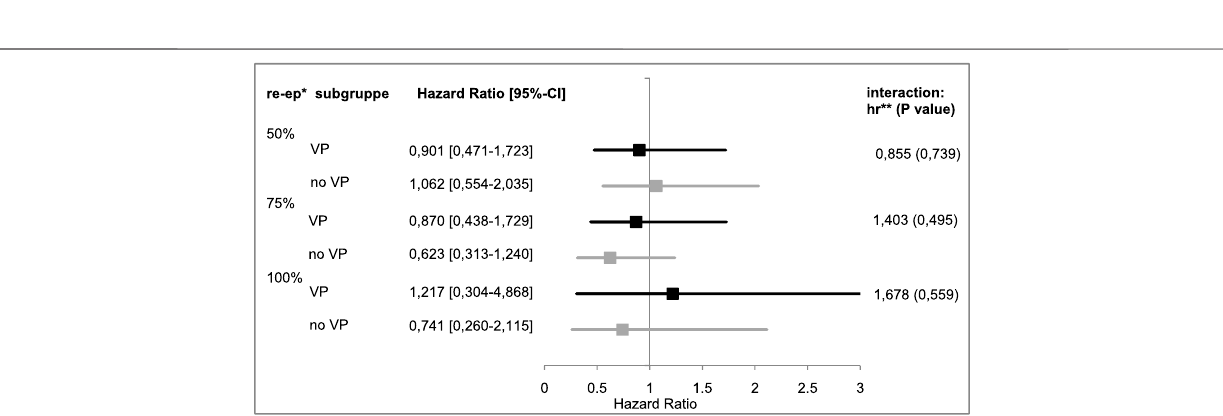
FIGURE 5 | Hazard ratios of subgroup “ NSARs > 1 ” vs. “ NSAIDs ≤ 1 ” . *re-ep, re-epithelialization level; **hr, hazard ratio; represents the therapeutic effect of EPO withits95% ¬ con fi denceintervalinthesubgroup,ahr < 1representsanegativetherapeuticeffectforthepatientswhoreceivedEPO;theinteractioneffectsarelistedon the right.